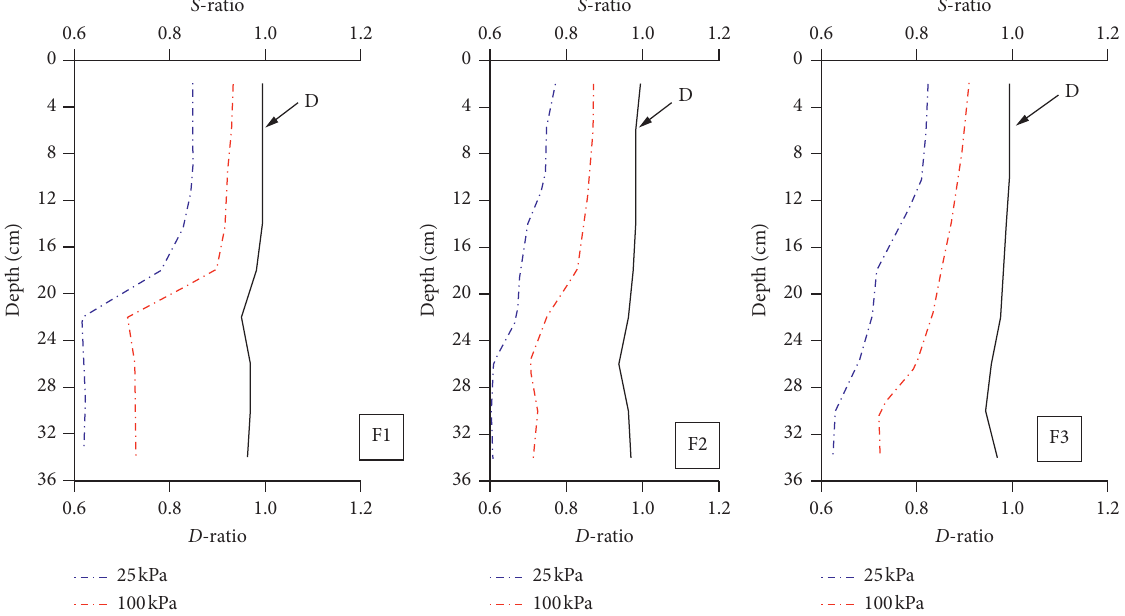
Figure 9: Shear strength ratio ( S -ratio) versus dry density ratio ( D -ratio) at the expansive soil columns’ different depths after the freeze-thaw